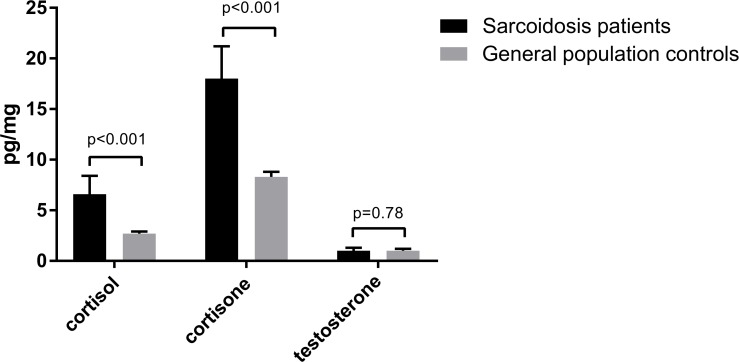
Hair cortisol, cortisone and testosterone levels in patients with sarcoidosis and general population controls [23, 24].Cortisol and cortisone were measured in 32 sarcoidosis patients and in 293 general population controls. Testosterone was measured in 13 male sarcoidosis patients and in 62 male general population controls. Data are shown as geometric mean (95% CI), and corrected for age and gender. General Linear model–Univariate (ANCOVA) was used for analysis.